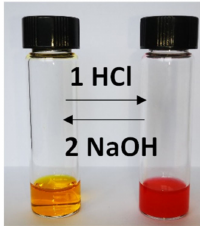
Figure 6. Acetonitrile solution of I–azo–NH2 (left) and after acidic treatment